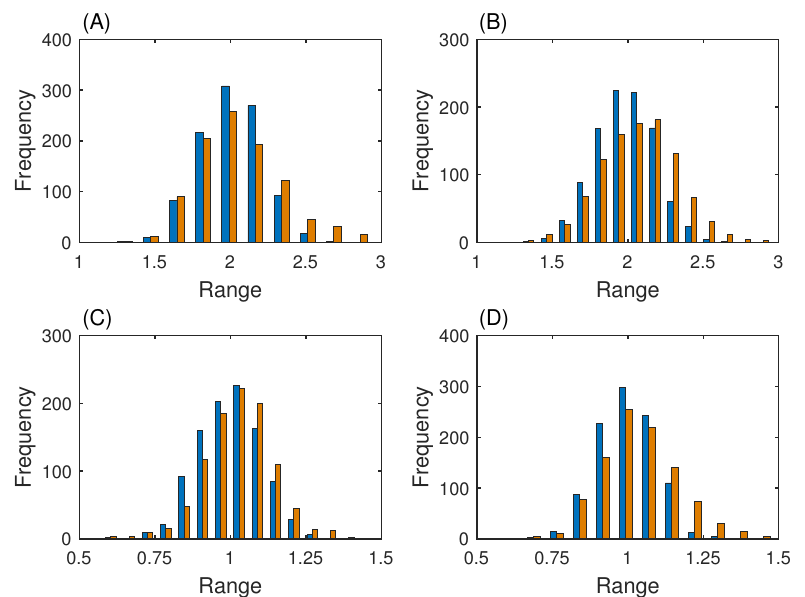
Figure 3. Simulated distributions of the parameters of Model (5). ( A ) Parameter a . ( B ) Parameter b . ( C ) Parameter k 1 . ( D ) Parameter k 2 (orange bar: distributions of simulated parameters, blue bar: distributions of exact